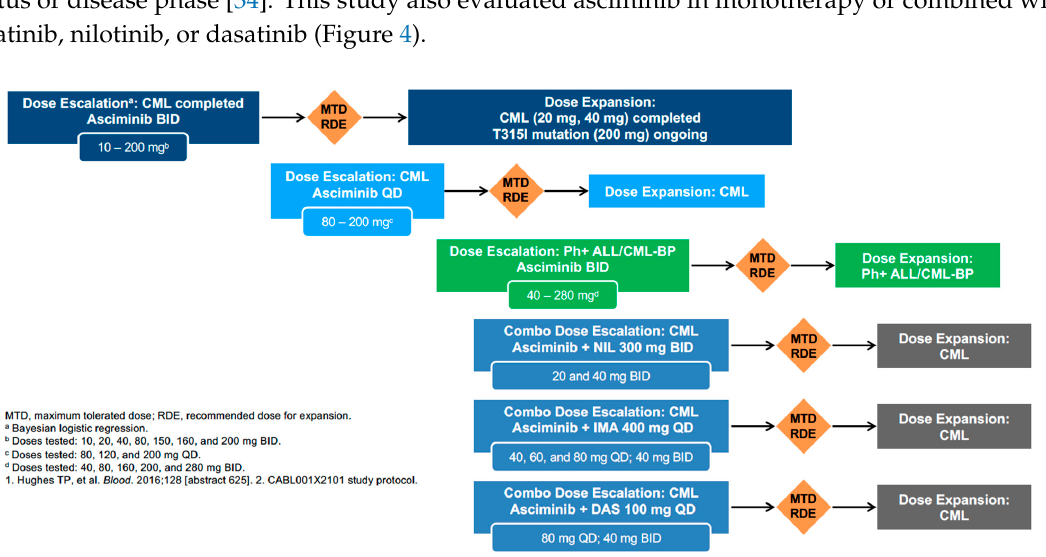
Figure 4. Phase 1 FIH study: single agent in CML/ALL and combinations in combinations in CML (CABL001 × 2101). NIL = nilotinib; BID = twice a day; QD = once a day; MTD: maximum tolerated dose; RDE: recommended dose for expansion.